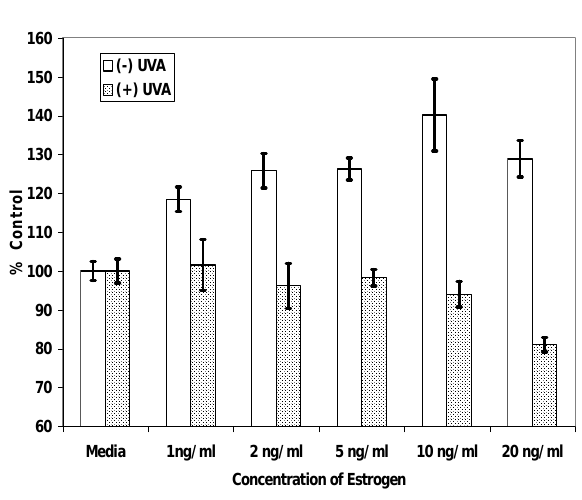
Figure 1: Cell viability of Jurkat T cells at different concentrations of estrogen ± UVA.